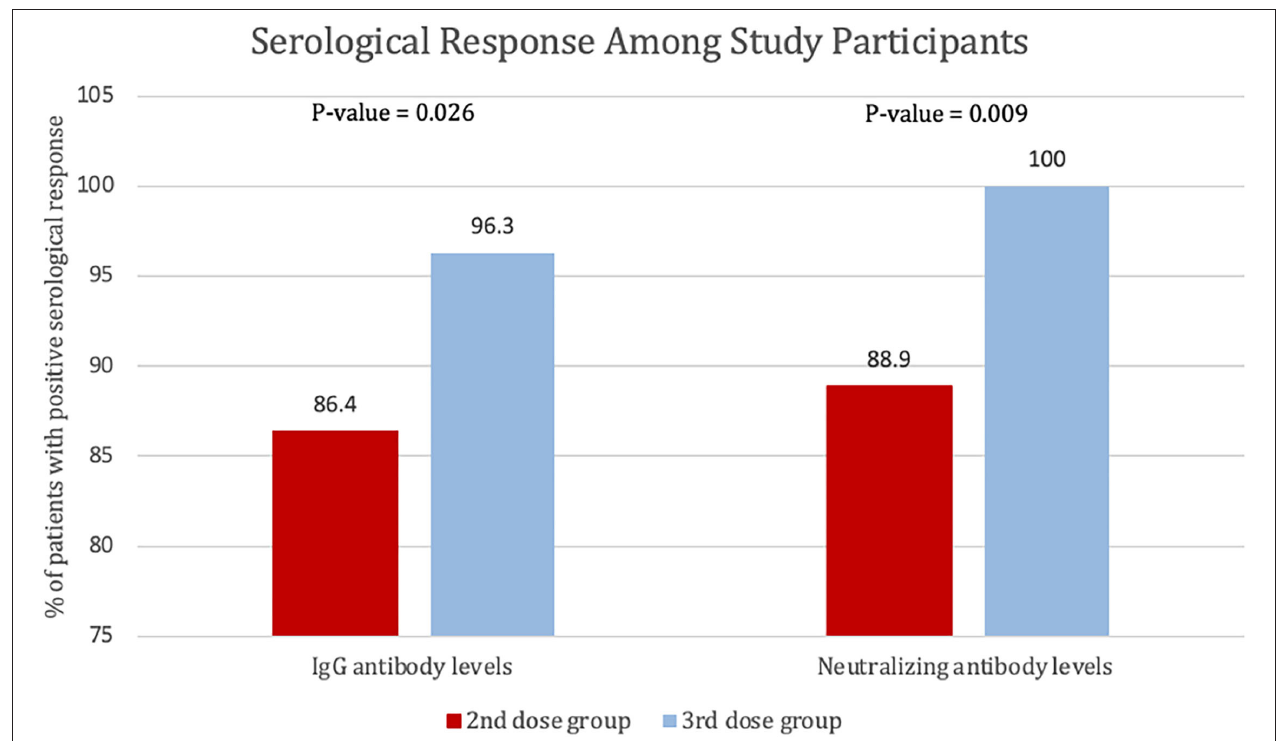
FIGURE 4 | Percentage of patients with positive serological response to the second and third dose of BNT162b2, defined by SARS-CoV-2 IgG antibody levels of > 31.5 BAU/ml or SARS-CoV-2-neutralizing antibody levels >